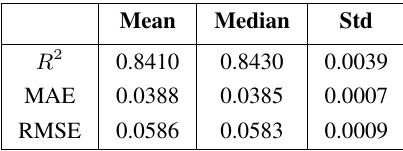
Table 1. SenDVI regression scores over